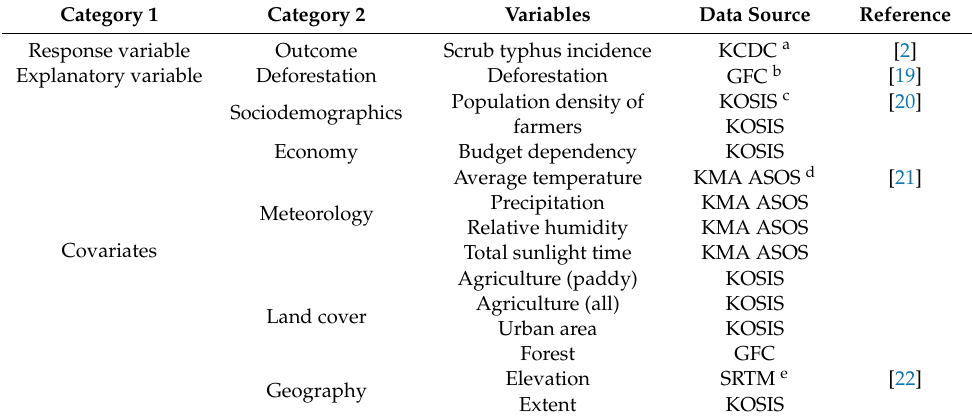
Table 1. Data acquired in this